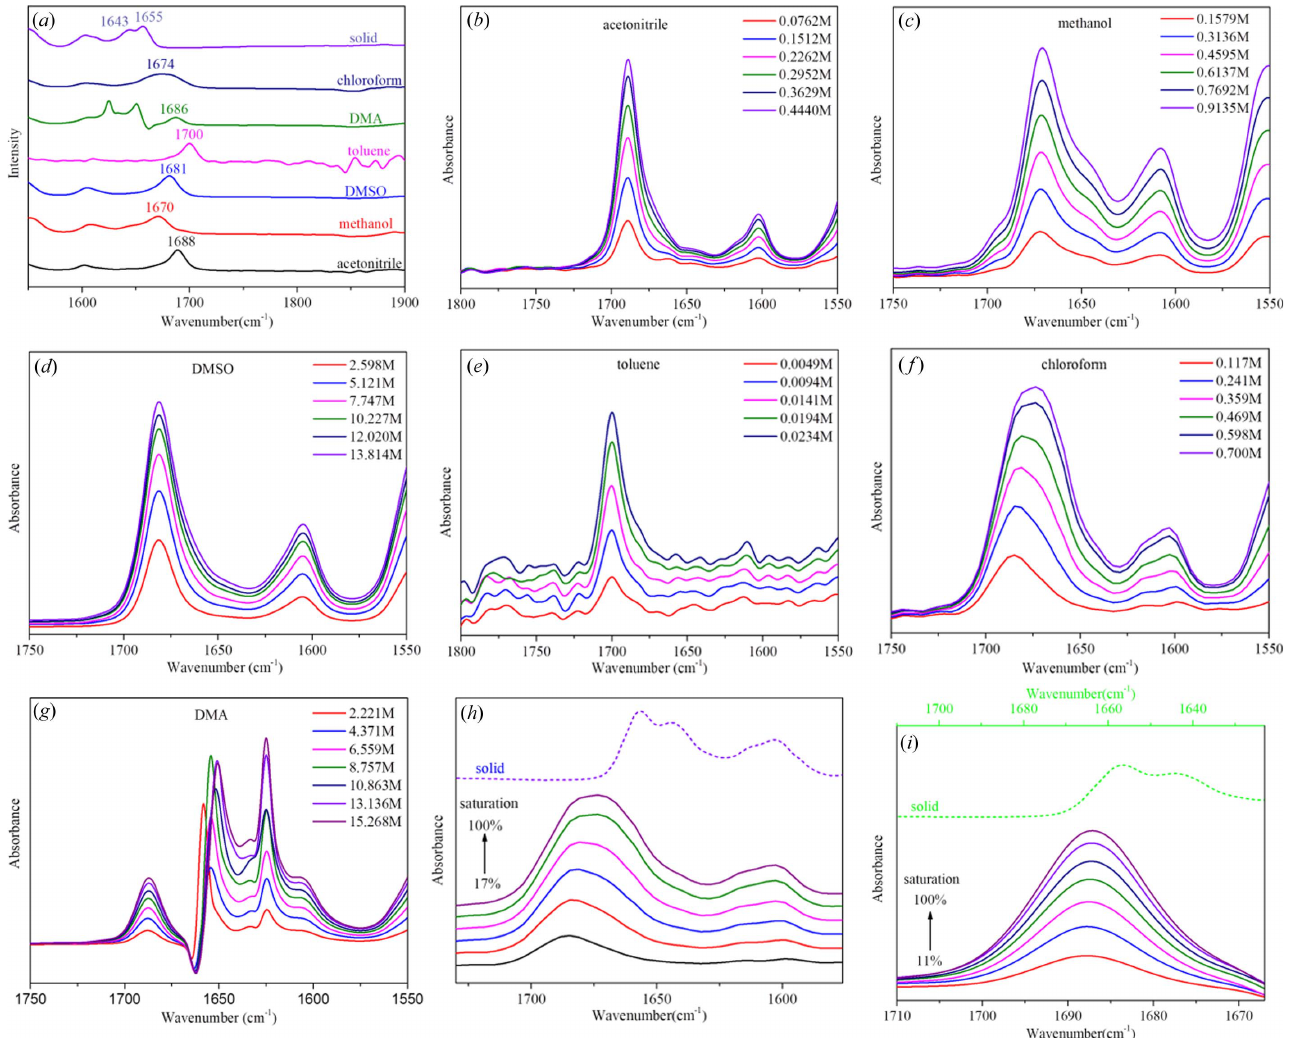
Figure 7 ( a ) IR spectra of PHEN form I and PHEN solutions in different solvents; ( b )–( g ) IR spectra of PHEN solutions in acetonitrile, methanol, DMSO, toluene, chloroform and DMA at different concentrations; ( h ) FTIR data of PHEN and PHEN in chloroform at different concentrations; ( i ) FTIR data of PHEN and PHEN in DMA at different concentrations. The solvent spectrum has been subtracted from all the solution